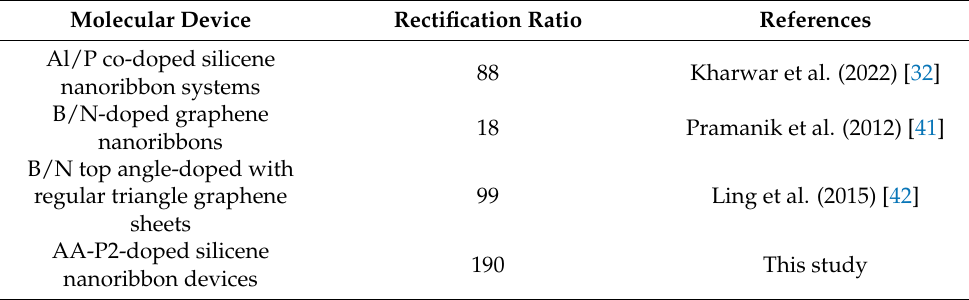
Table 1. Comparison of the maximum rectification ratio of different